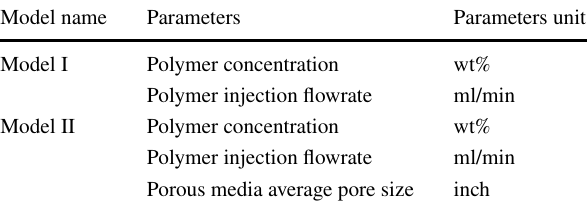
Table 1 Properties of mathematical